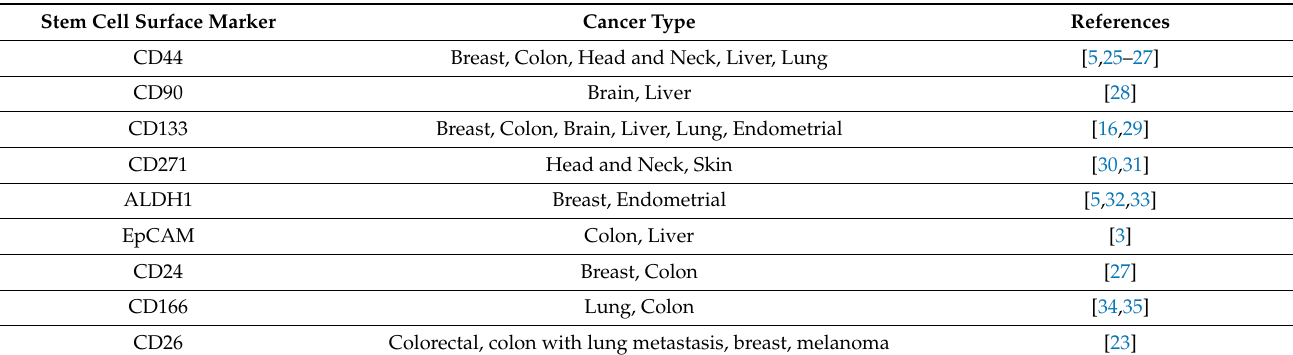
Table 1. Stem cell surface markers in various